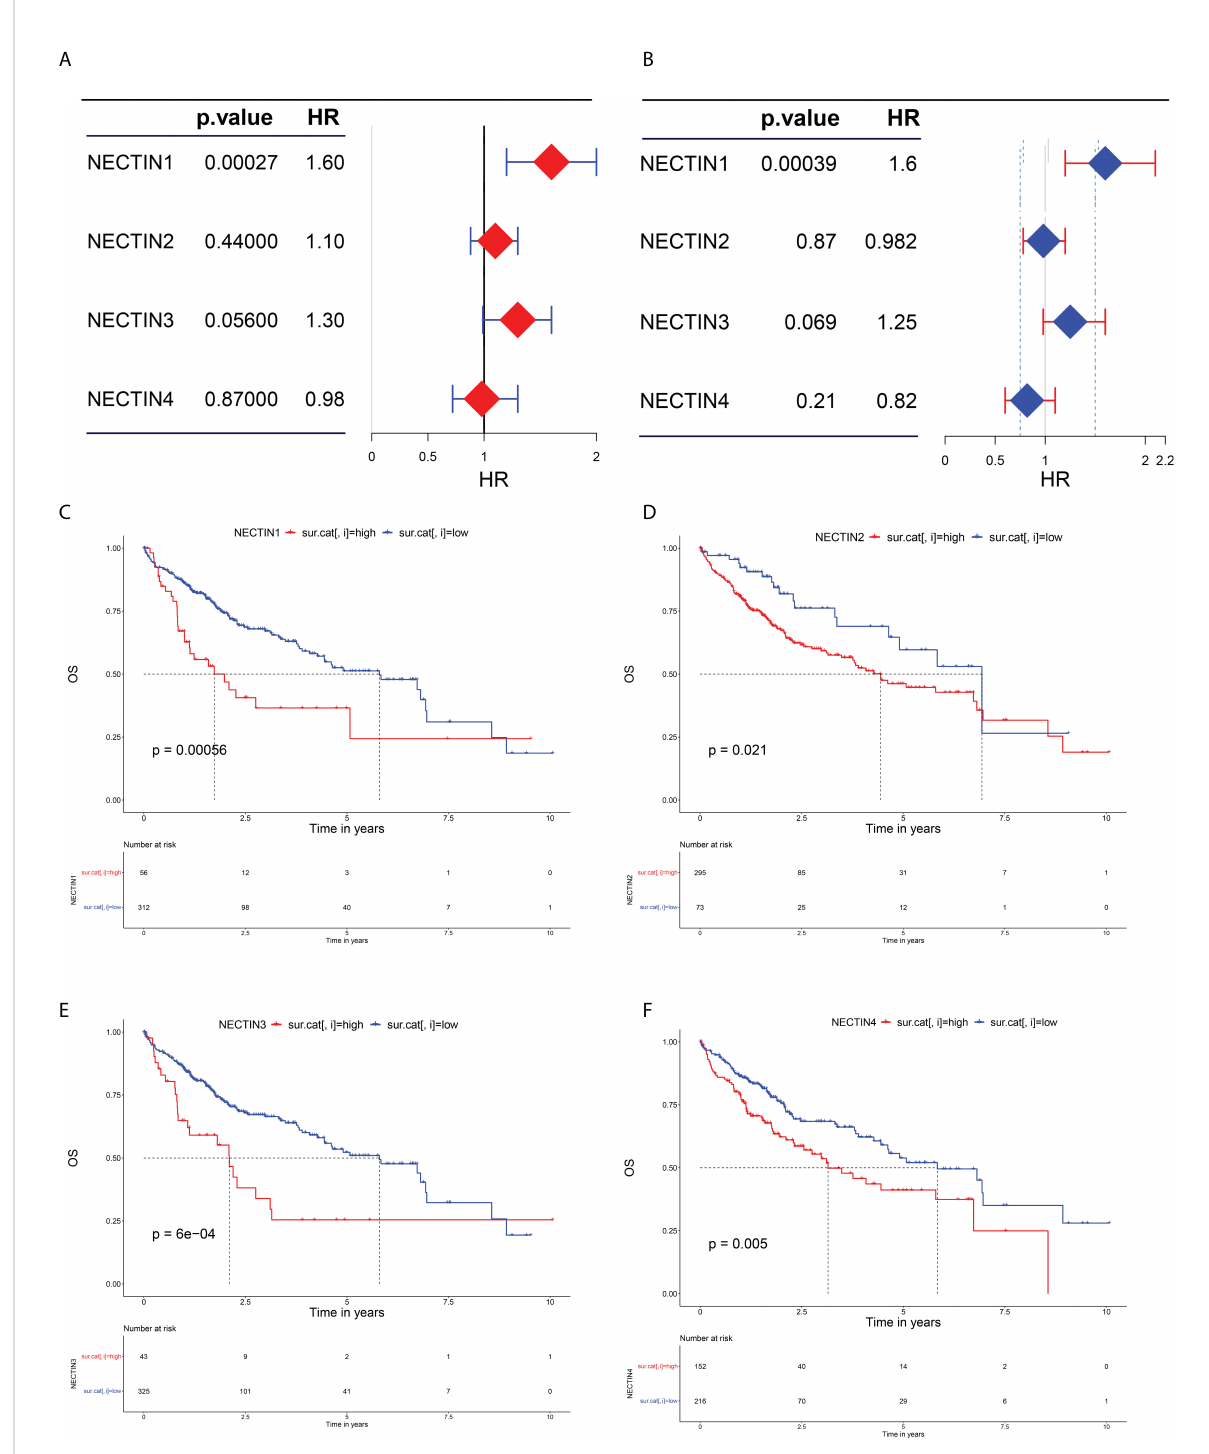
FIGURE 2 Evaluation of nectin-1, nectin-2, nectin-3, and nectin-4 genes and prognosis in patients with HCC. (A) Univariate analysis of nectin-1, nectin-2, nectin-3, and nectin-4 and overall survival rate of HCC patients plotted by “ forestplot. ” (B) Multivariate analysis of nectin-1, nectin-2, nectin-3, and nectin-4 and overall survival rate of HCC patients plotted by “ forestplot. ” (C) K-M plotter of nectin-1 gene expression and OS in HCC patients. (D) K-M plotter of nectin-2 gene expression and OS in HCC patients. (E) K-M plotter of nectin-3 gene expression and OS in HCC patients. (F) K-M plotter of nexin-4 gene expression and prognosis of HCC